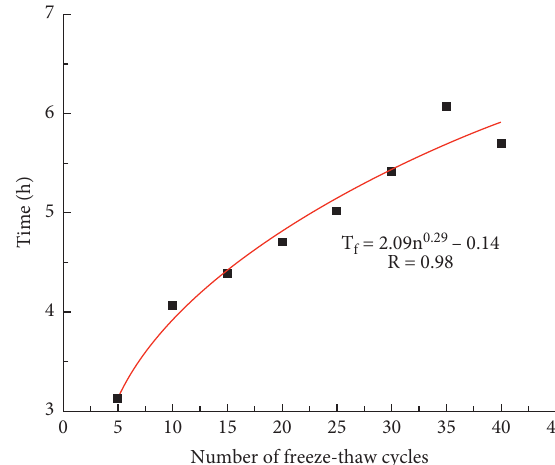
Figure 8: Variations in the time required for the melting process as a function of the number of freeze-thaw